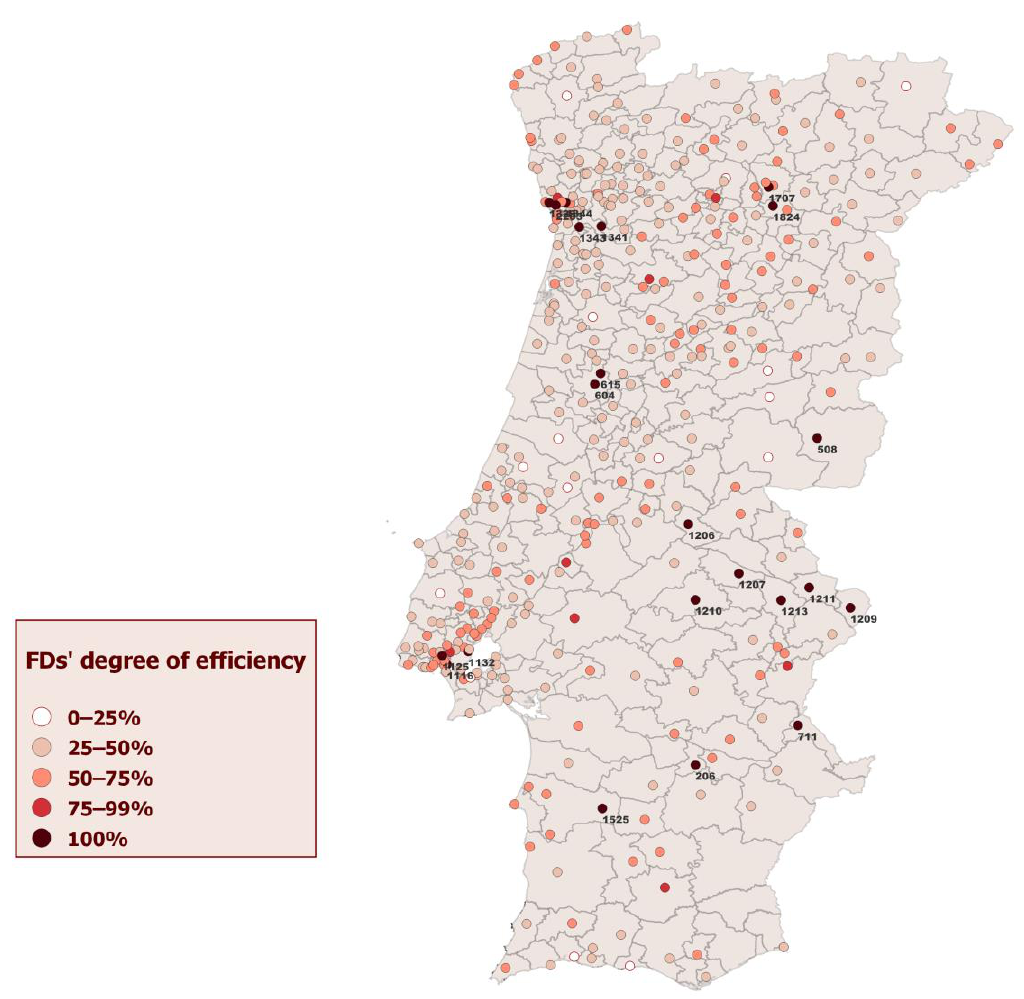
Figure 6. Efficient FDs and their number of appearances in the reference sets as targets for other FDs.